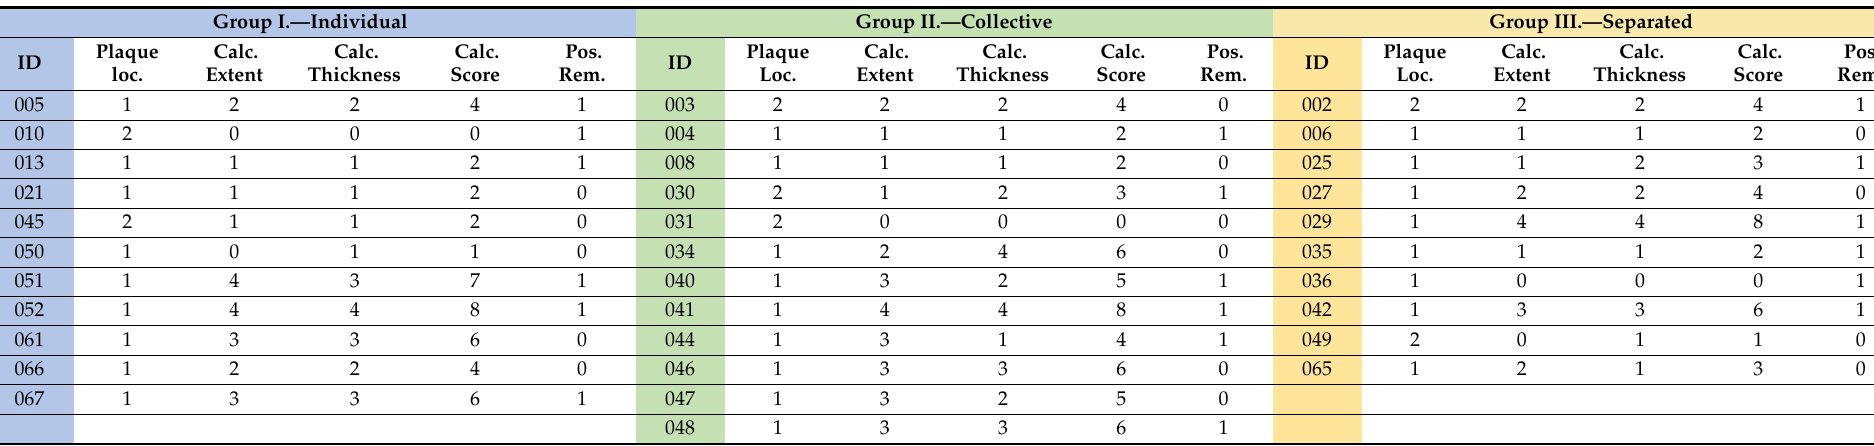
Table 1. The results of the variables from the image evaluation of the homogenous groups. The following grouping variables were used: plaque localization (1: bifurcation, 2: suprabulbar), plaque calcification (extent 0–4 and thickness 0–4 score is the sum of the extent and thickness values; (Babiarz 2003) [20]) and plaque remodeling (no: 0 yes: 1; (Yosida 2015) [21]). Group I.—Individual Group II.—Collective Group III.—Separated Plaque Calc. Calc. Calc. Pos. Plaque ID loc. Extent Thickness Score Rem.